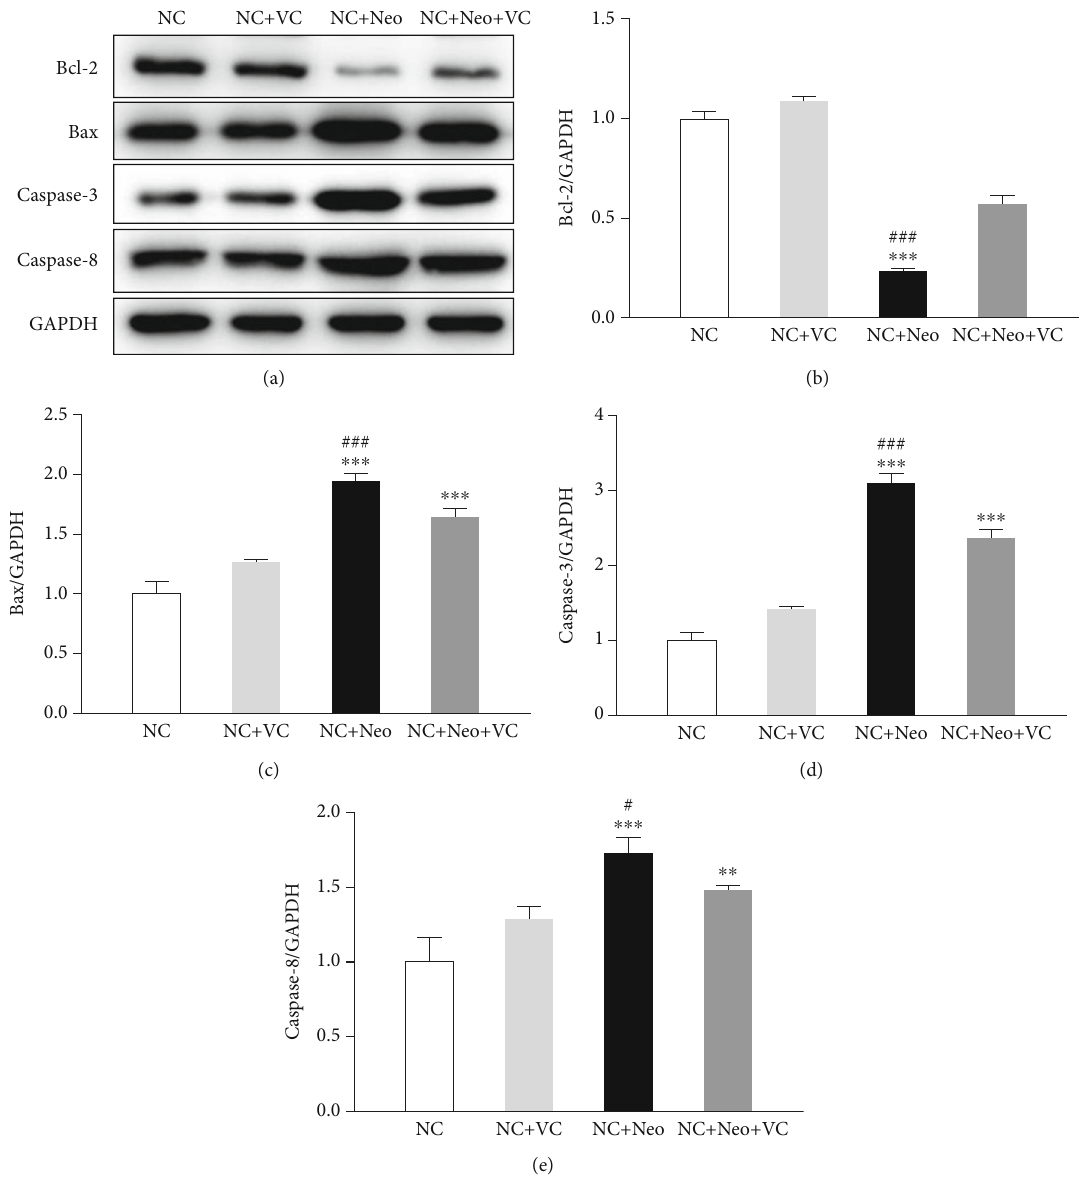
Figure 9: Apoptotic-related protein expression in treated HEI-OC1 cells. The expression of the apoptotic protein was detected by Western blot (a). Bcl-2, Bax, caspase-3, and caspase-8 proteins were detected. The protein expression level was measured with each band gray value, normalized with GAPDH (b – e). One-way ANOVA, ∗∗ p < 0 : 01 and ∗∗∗ p < 0 : 001 versus NC group and # p < 0 : 05 and ### p < 0 : 001 versus NC +Neo+VC group. All tests were repeated three times